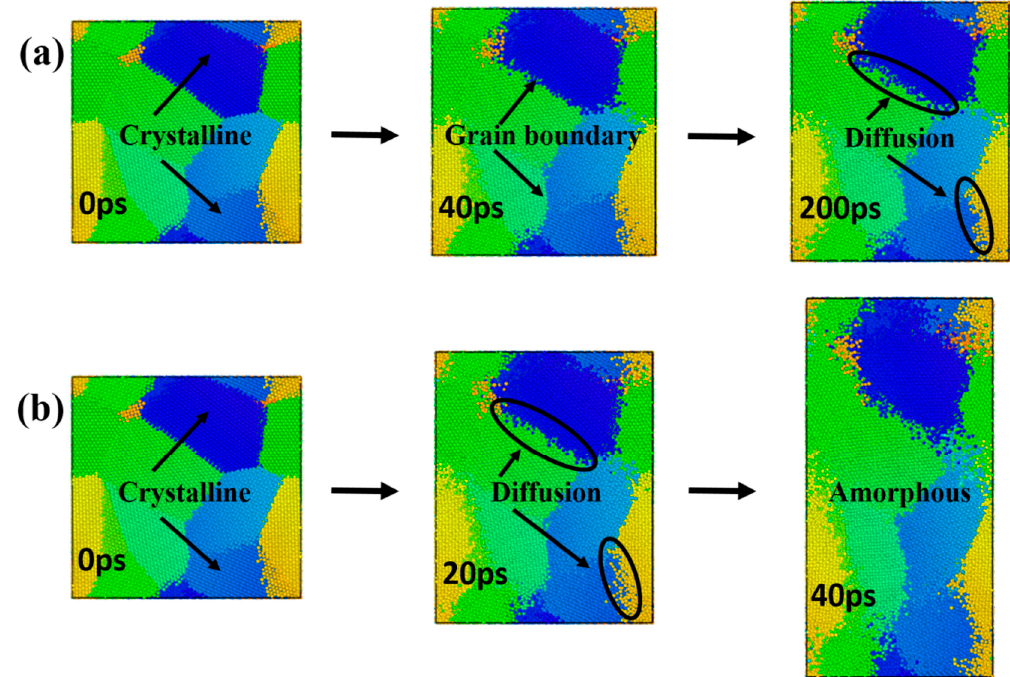
Figure 6. Atomic snapshots of nanocrystalline NiAl models with a grain size of 4.5 nm under the stress level of 2.0 GPa at ( a ) 1200 K and ( b ) 1400 K during the creep process at the indicated times.